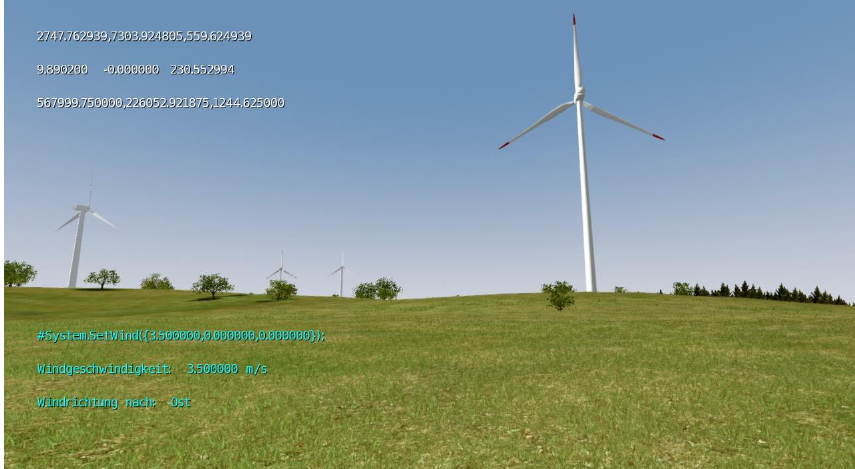
Figure 6. Overlaid head-up display (HUD) information of the current position in field and viewing angle (upper left corner) and the current wind speed and direction (bottom left